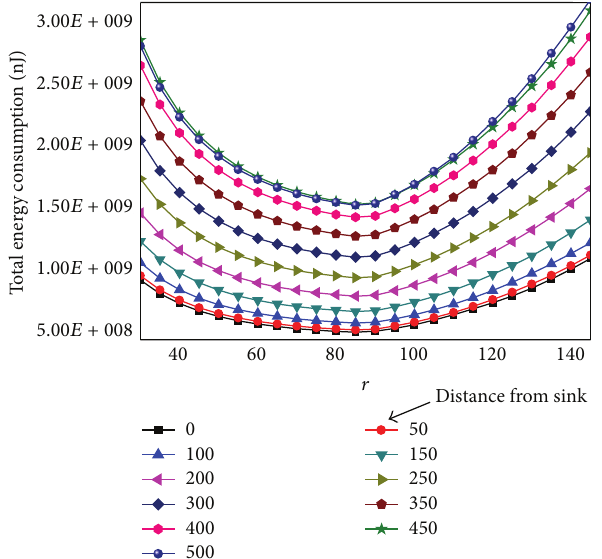
Figure 16: Overall energy consumption under different 𝑟 .